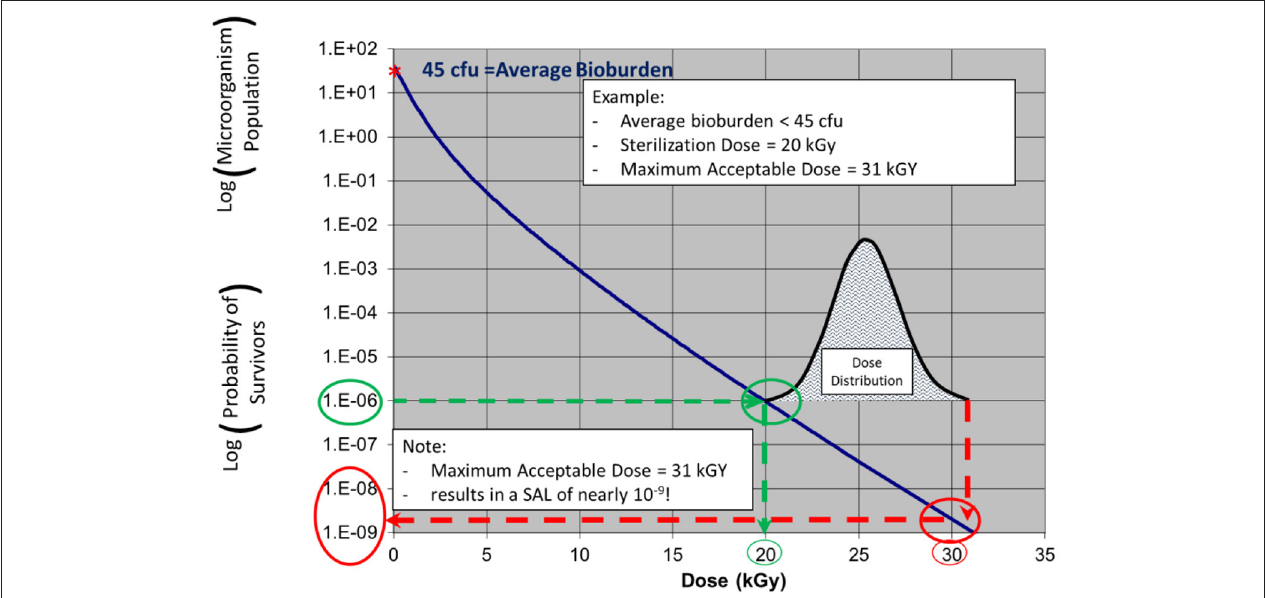
FIGURE 4 | ISO 11137 performance qualification—a relatively narrow dose mapping distribution highlighting significant additional lethality (conservativeness) to much of the product.